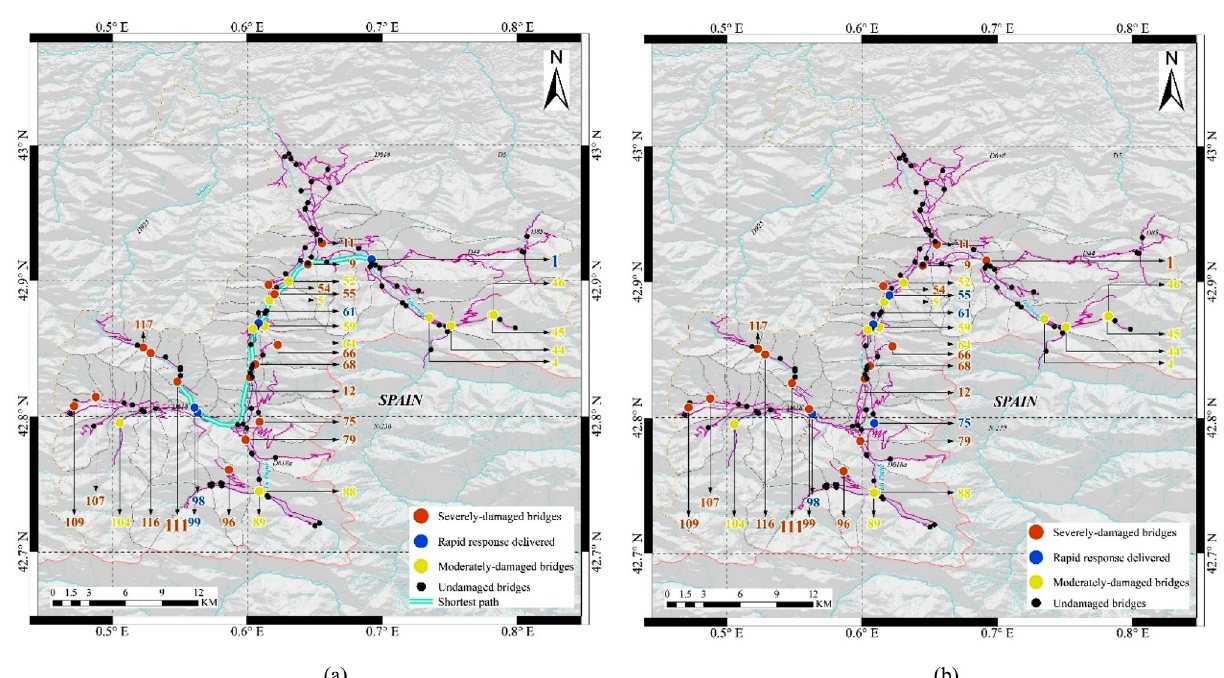
Figure 5. Global damage status of the Road Network at “critical” decision-moment. The plot is a “snapshot” of the damage status of the global RN at the 4th decision-moment of ( a ) the betweenness-based strategy , and ( b ) the learning-based strategy , respectively. The trajectory of the rapid response guided by those two different strategies significantly diverge thereafter, having a far-reaching impact on the whole campaign. The figures are plotted by